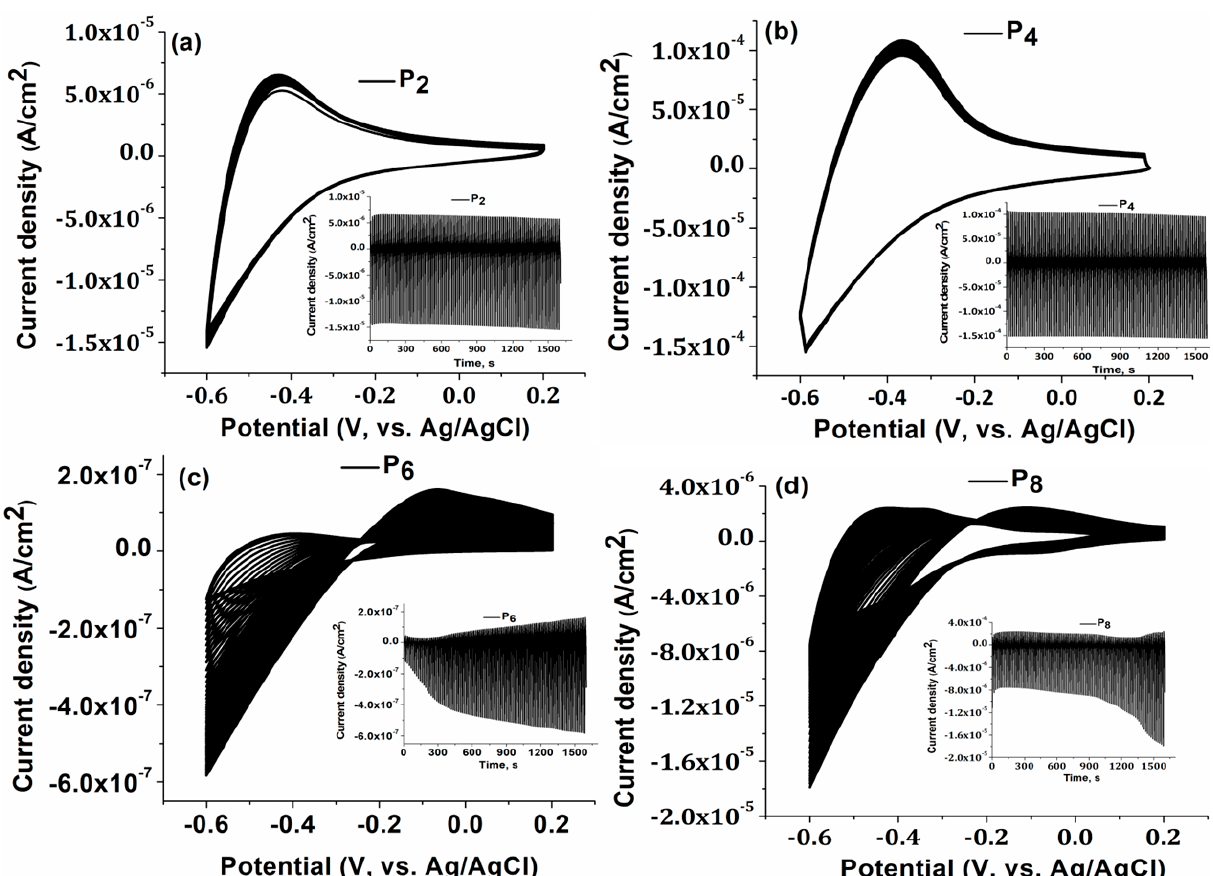
Figure 4. Cycle Voltammetry for ( a ) P 2 ; ( b ) P 4 ; ( c ) P 6 ; ( d ) P 8 between − 0.6 V and 0.2 V vs. Ag/AgCl at 50 mV s − 1 , 100 cycles, in 0.5 M H 2 SO 4 aqueous solution.